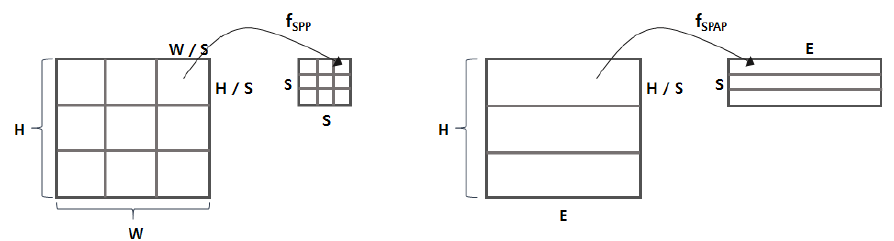
Figure 3. Comparison between the SPP and the SPAP. ( left ) The SPP working on a two-dimensional image; ( right ) the SPAP working on a stream of embedding vectors.